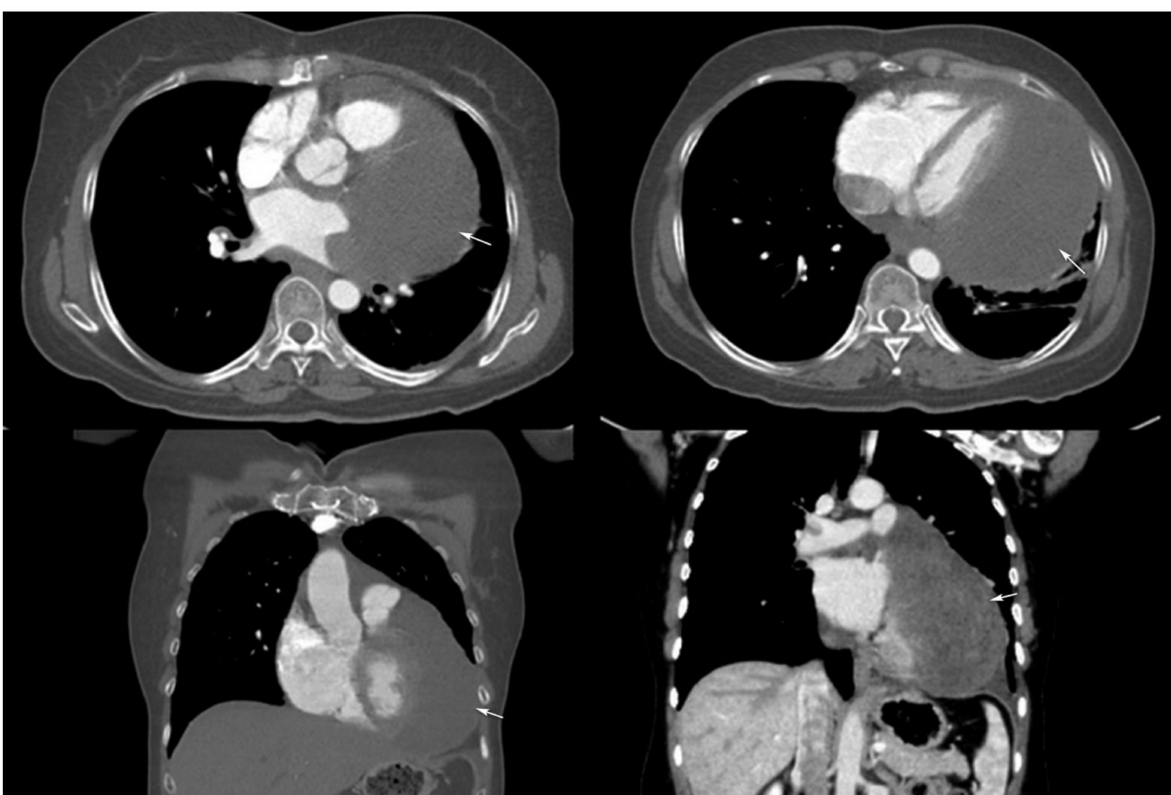
Figure 6. At 18 months, a follow-up CT with contrast enhancement—axial (upper images) and coronal (lower images) plane reveals a homogeneous tumor relapse near the left heart border (arrows), invading the left atrium, right superior pulmonary vein and periaortic